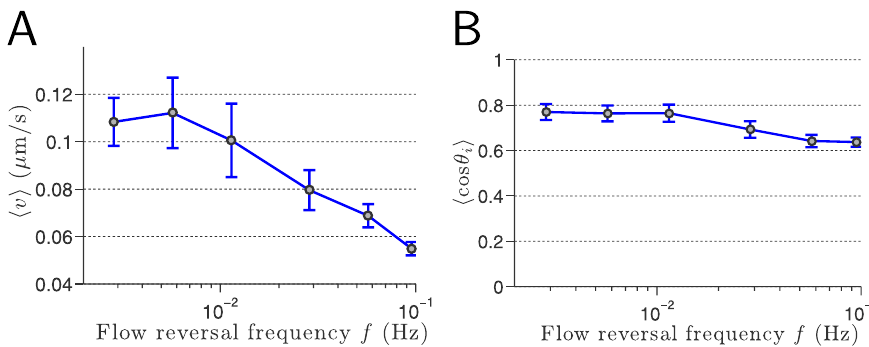
Figure 7. Effects of flow reversal frequency on cellular directionality. (A) Pack average speed S u T as a function of the flow reversal frequency f using a log-scale. Beyond the trapping frequency f t ~ 1/17.5 Hz, the pack speed is still significant: S u T ^ 0 : 05 m m : s { 1 which is to be compared to the average cell speed S u i T ^ 0 : 089 m m : s { 1 found for the uniform one-dimensional translation along the signal direction. (B): Average S d vs. flow reversal frequency. The average directionality does not follow the same trend as the pack speed: it decreases sensibly with f . Even when cells are effectively trapped, they still exhibit a fairly high directionality, close to a value of 0 : 6 .